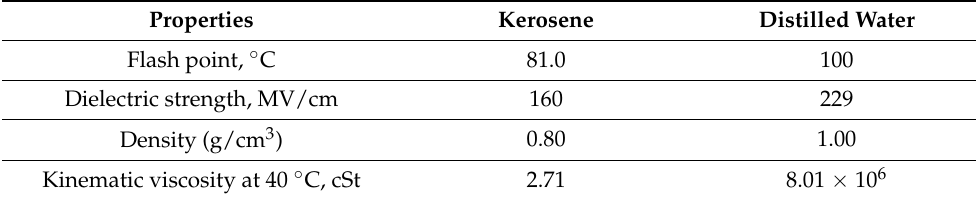
Table 3. Properties of dielectric fluids